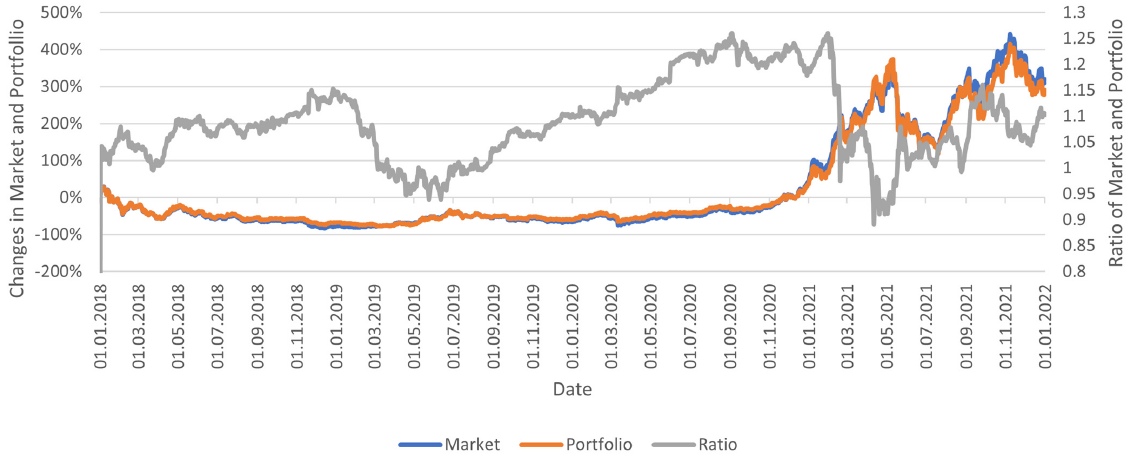
Figure 6. Changes in the portfolio and cryptocurrency market prices of individual analyzed indices in the analyzed period.